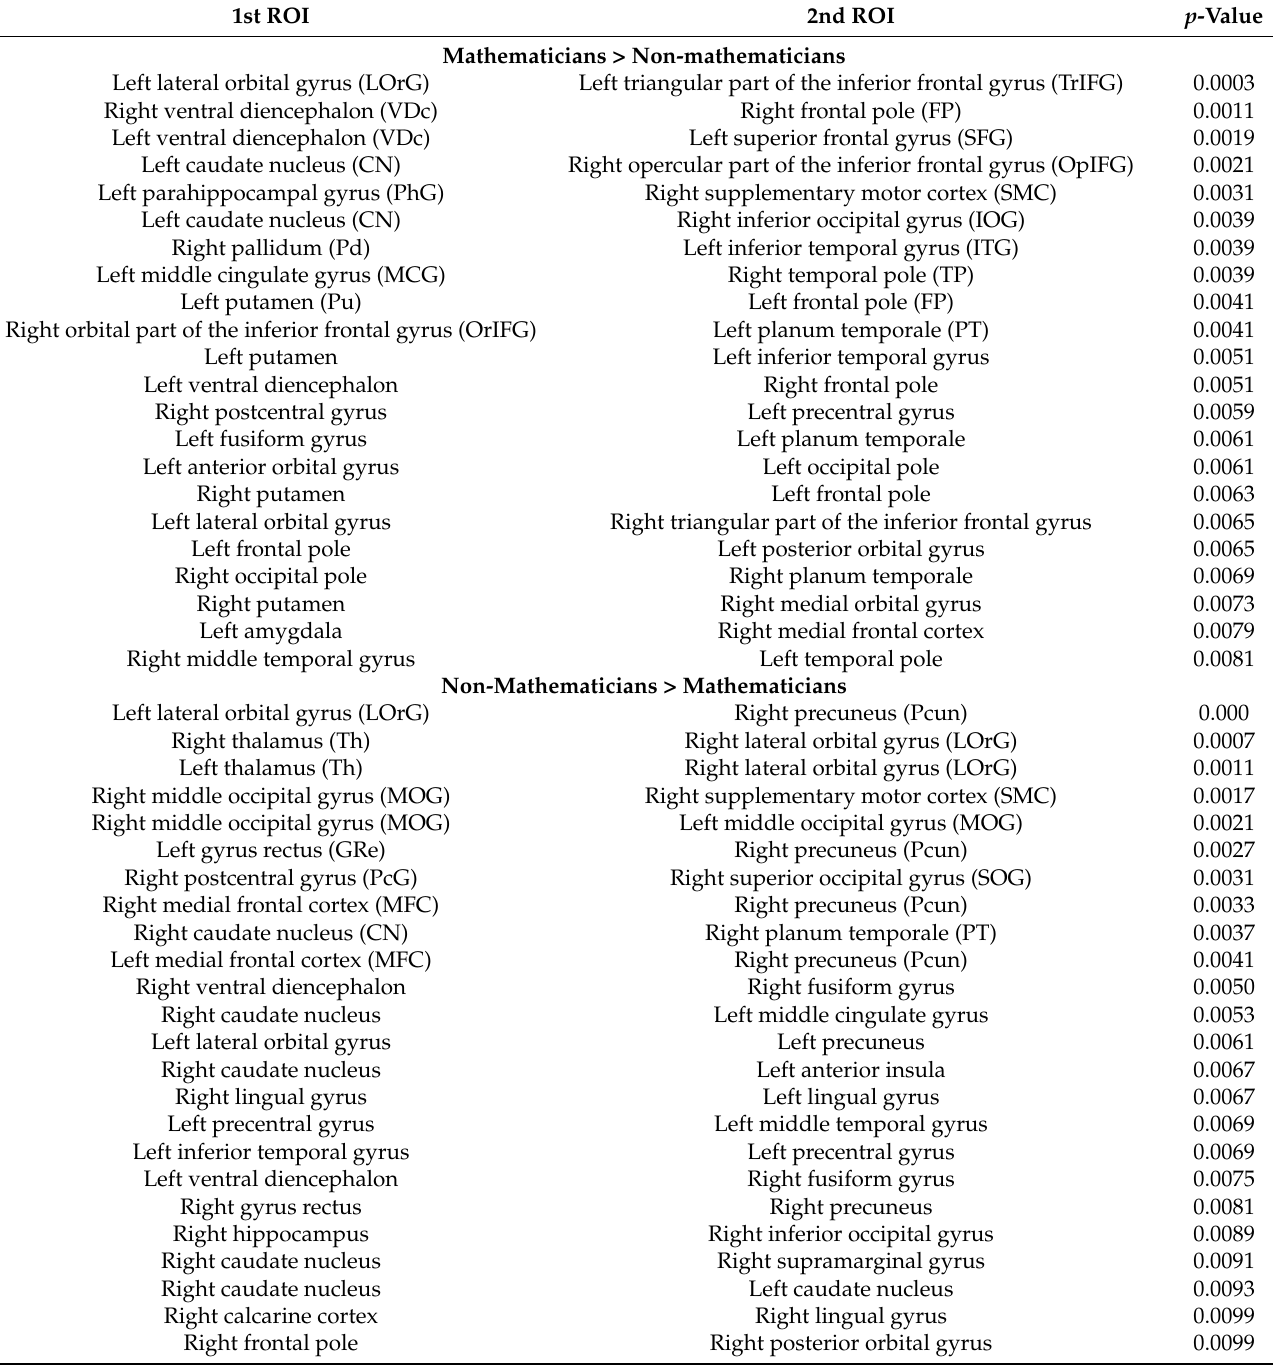
Table 2. List of region of interest (ROI) pairs showing statistically significant differences between mathematicians and non-mathematicians in terms of functional